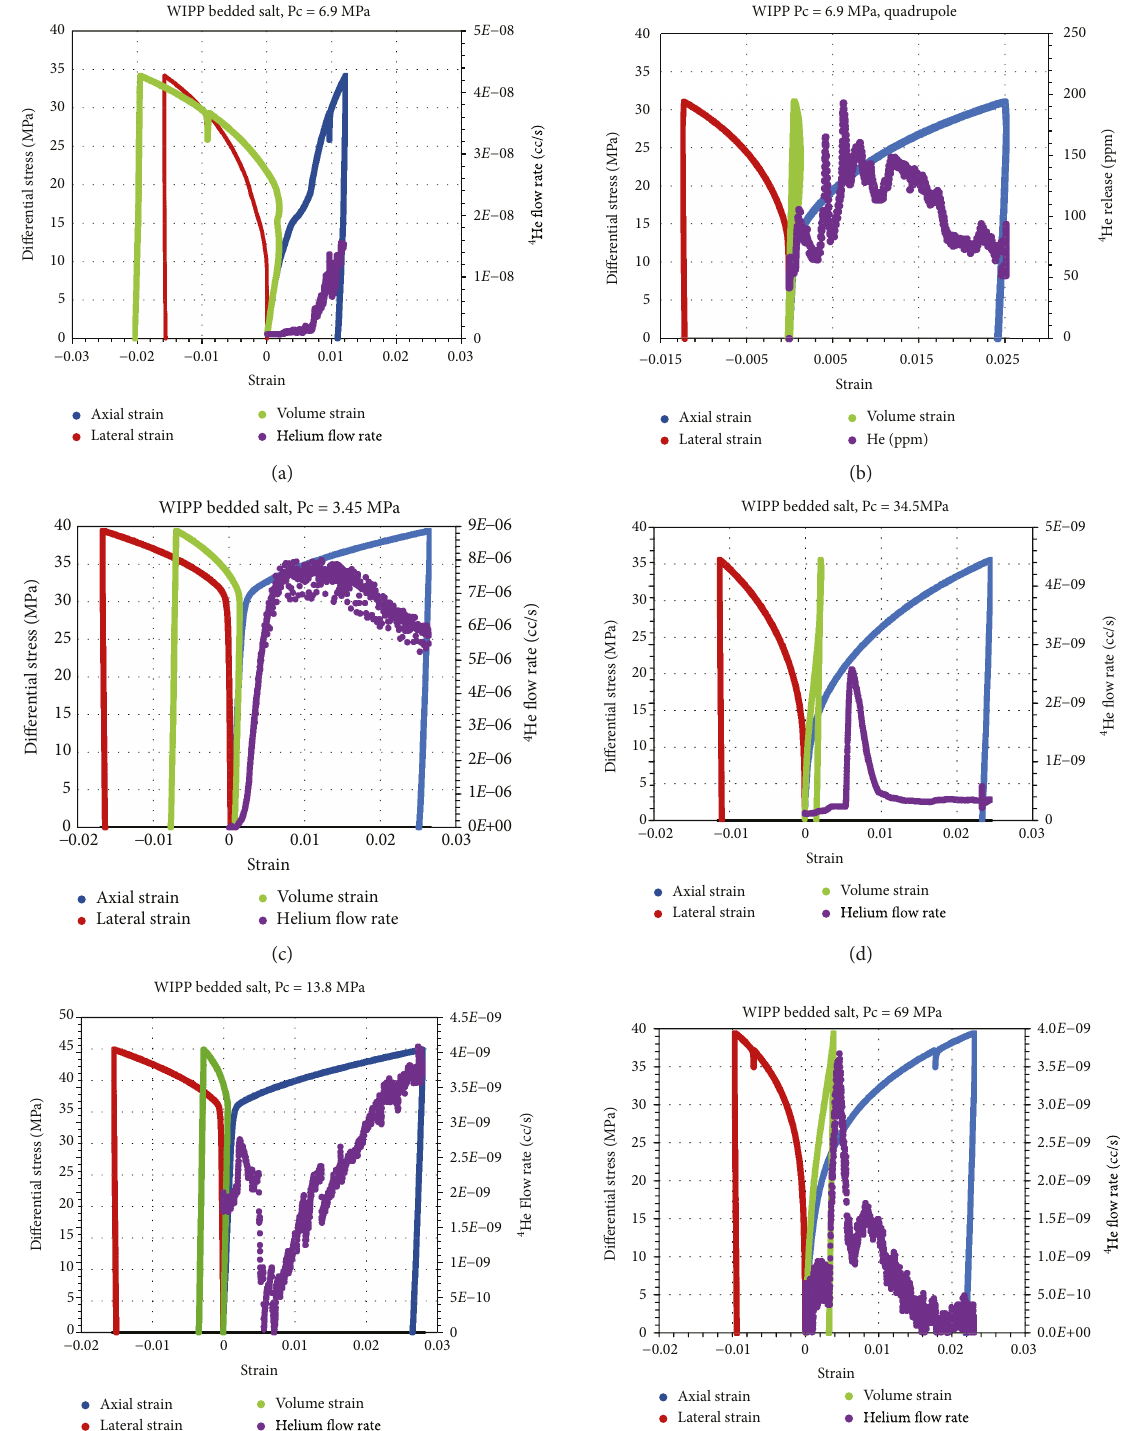
Figure 5: Di ff erential stress versus strain and helium fl ow rate (a, c, d, e, f) and helium release (b) versus axial